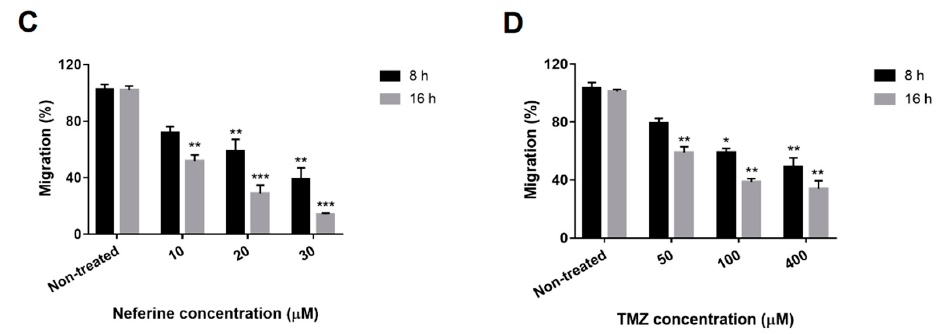
Figure 6. Neferine inhibits migration in human neuroblastoma cells. (A,B) IMR32 cell monolayer was scratched and treated with neferine (A) or TMZ (B) in time ‐ dependent manner for wound ‐ healing migration assay. Images were accessed by inverted microscope. (C,D) The quantification of cell migration in wound healing assay after treatment with neferine (C) or TMZ (D) were measured. Data are shown as percentages of the recovered scratch area relative to non ‐ treated control. Results are presented as mean ± SD in three independent experiments. * p < 0.05, ** p < 0.01, and *** p < 0.001 as compared with the non ‐ treated control.